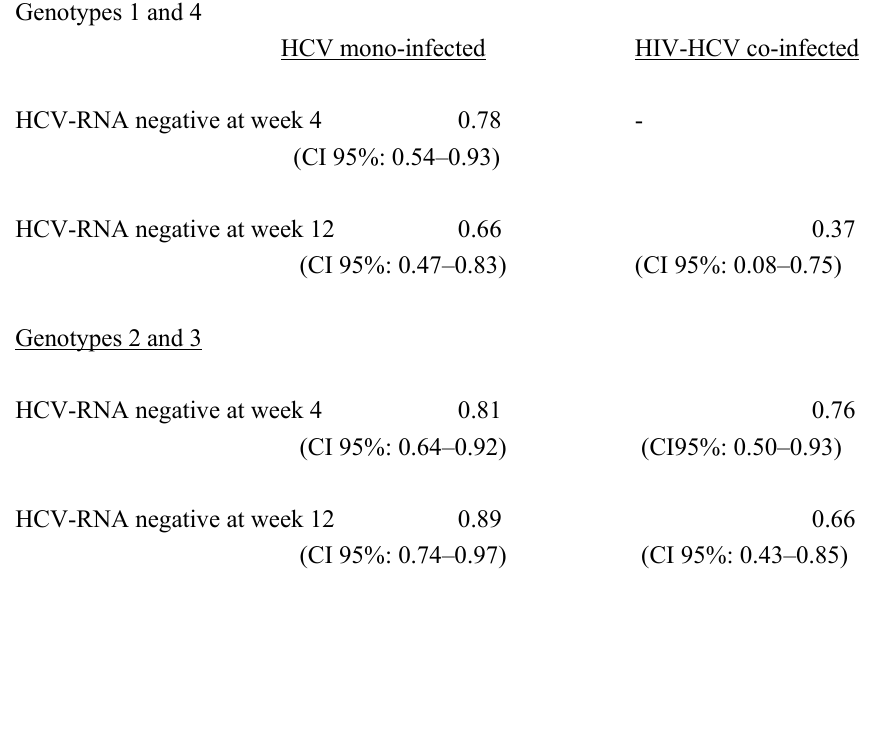
Genotypes 1 and